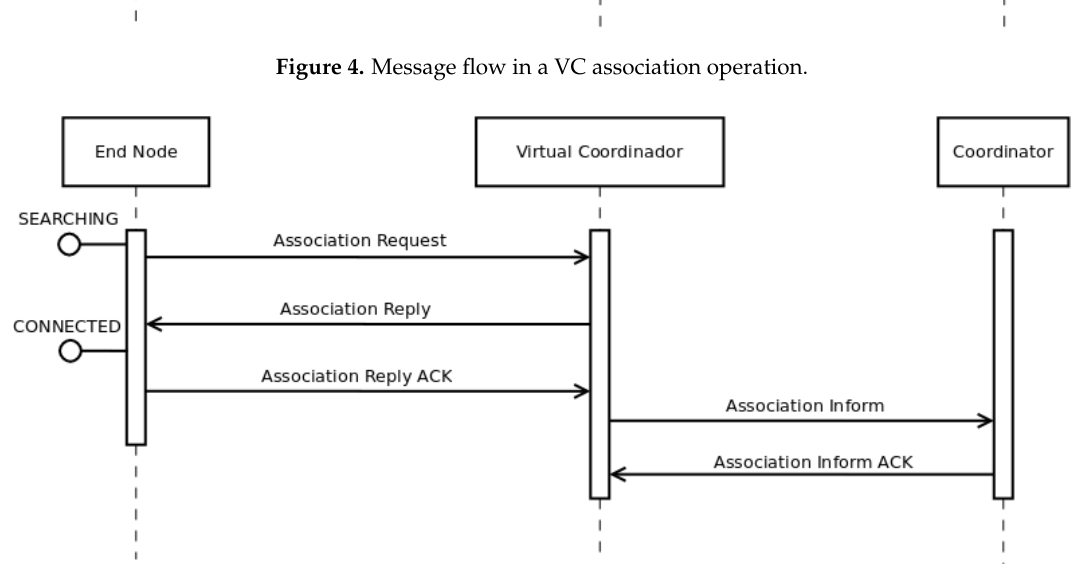
Figure 4. Message flow in a VC association operation.